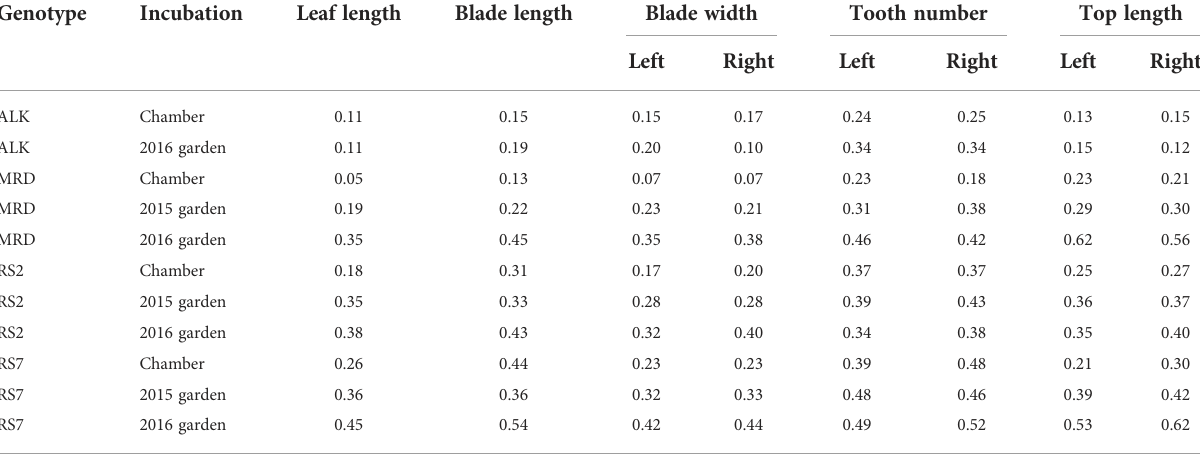
TABLE 1 CV values of each leaf trait.